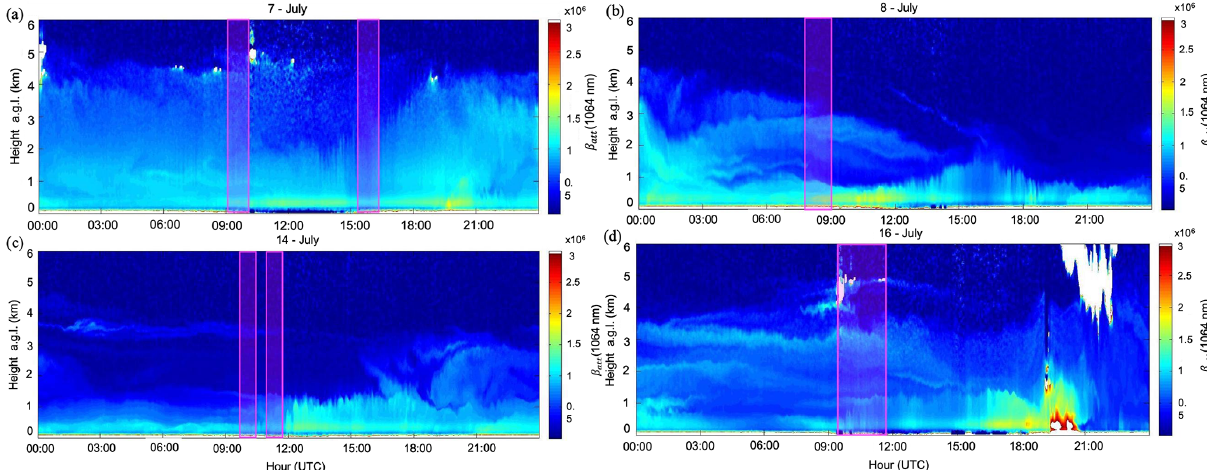
Figure 6. Time evolution of β att vertical profiles as retrieved by the ceilometer deployed at the MSA station during the July 2015 measurement campaign for (a) 7, (b) 8, (c) 14 and (d) 16 July. The shadowed boxes highlight the measurements during the flights